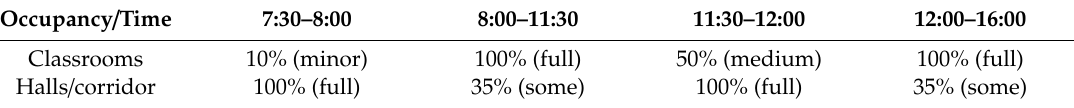
Table 2. Occupancy schedules used in the EnergyPlus